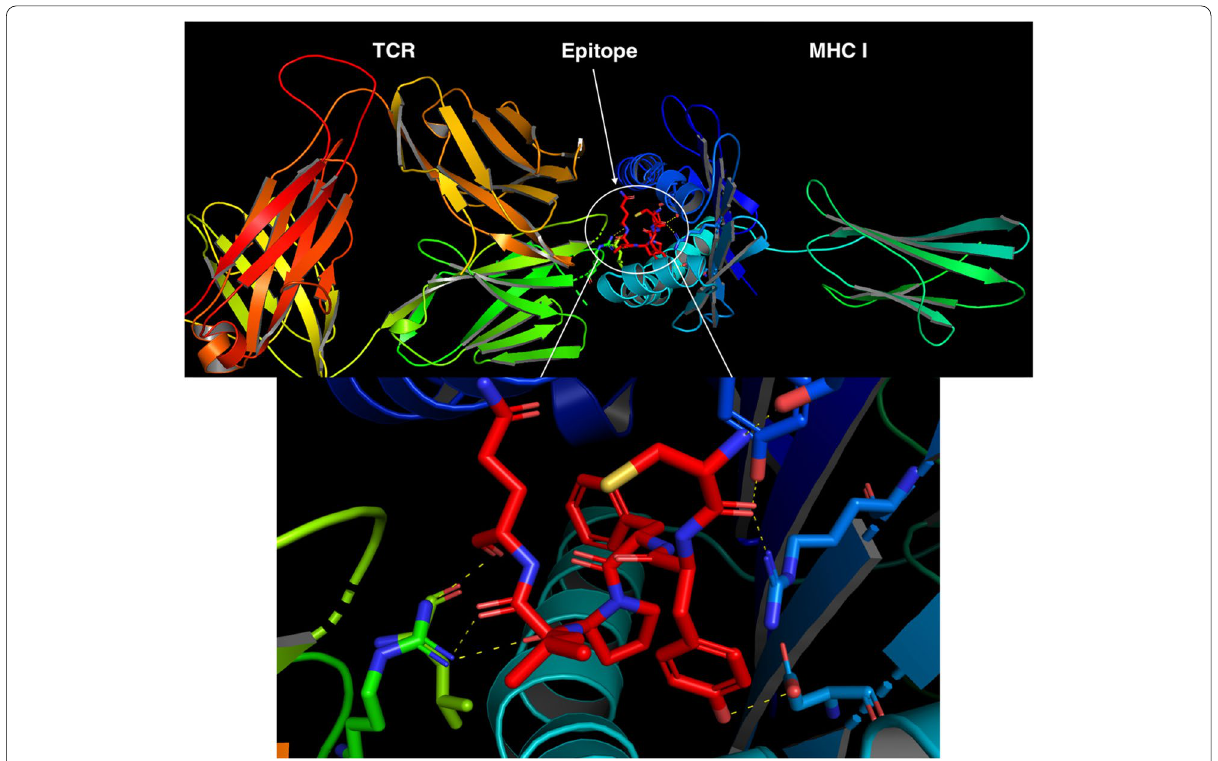
Fig. 4 Molecular docking of Spike epitope (No. 14 in Table 1) with both 4prp MHC I molecule and TCR